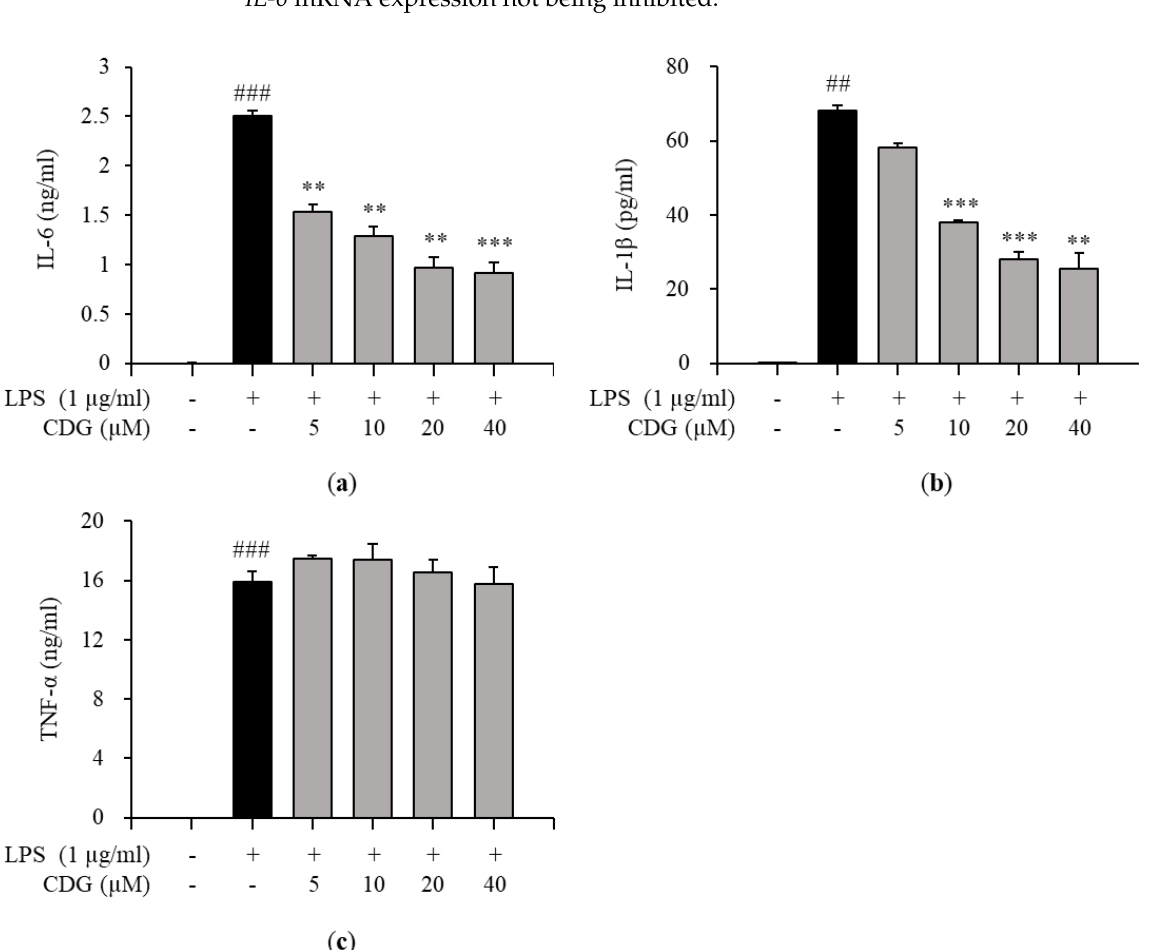
Figure 3. Effect of CDG on pro-inflammatory cytokine production. The ImKC cells were treated with CDG (5, 10, 20, and 40 µ M) for 2 h and stimulated by LPS (1 µ g/mL) for 24 h. After LPS treatment, the pro-inflammatory cytokine such as ( a ) IL-6, ( b ) IL-1 β , and ( c ) TNF- α production were measured and quantified using a standard curve. The pro-inflammatory cytokine production level is shown with a bar graph. Data are presented as the mean ± standard deviation. ## p < 0.01 and ### p < 0.001 relative to the untreated control group. ** p < 0.01 and *** p < 0.001 relative to the LPS-treated and CDG-untreated group. CDG, catechin- 7,4′ - O -digallate; LPS, lipopolysaccharide; IL, interleukin; TNF, tumor necrosis factor.